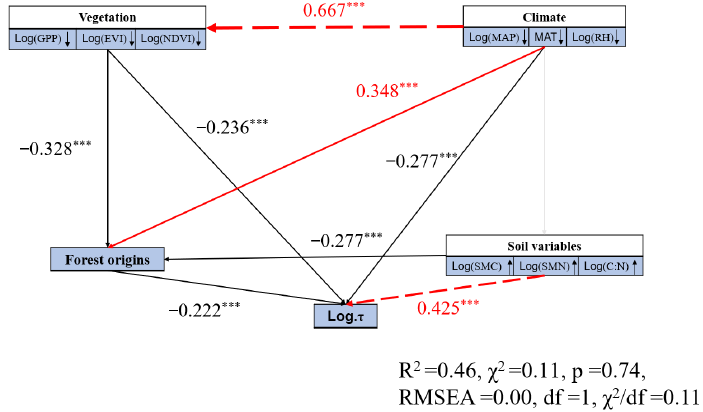
Figure A9. The main influencing factors of C turnover on the subsoil of DBF were obtained by the SEM model. The symbols “ ↑ ” and “ ↓ ” indicate a positive or negative correlation between environmental factors and subsoil τ . The goodness of fit statistics for the effect size model of the relationship are as follows: *** p < 0.001.